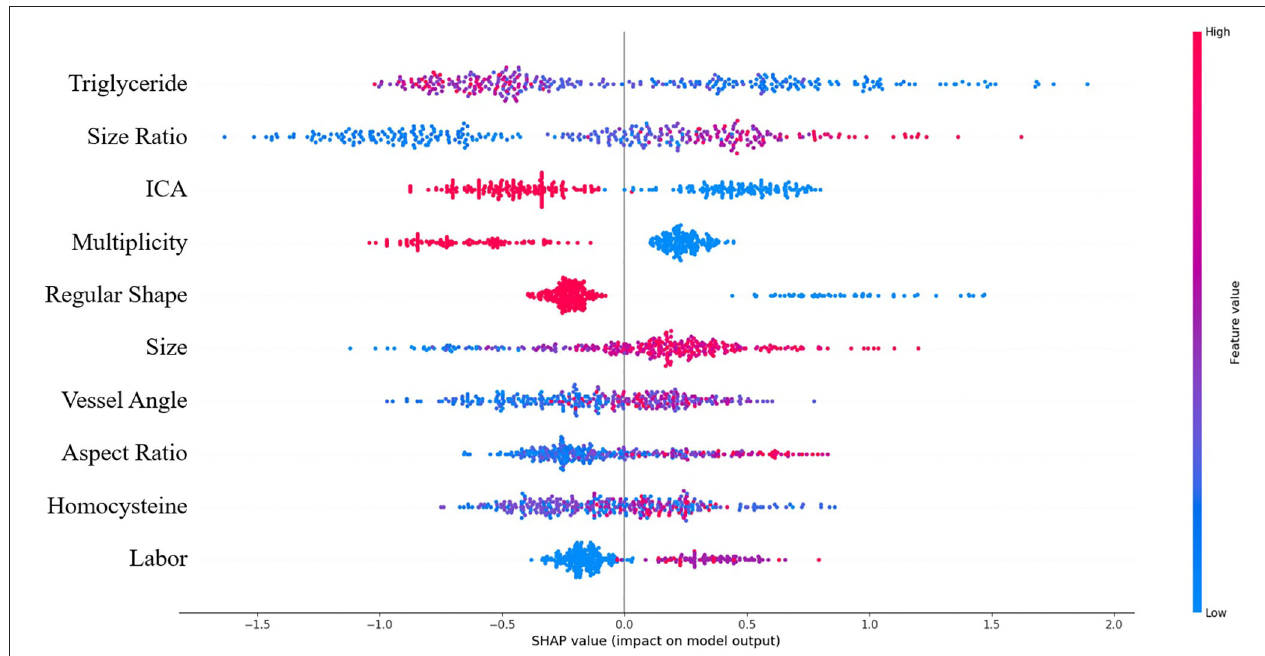
FIGURE 3 | Summary of SHAP analysis on the dataset. This shows the 10 most important features and their impact on the model output. Each dot represents a case in the dataset. The color of a dot indicates the value of the feature, with blue meaning the lowest range and red meaning the highest range. The horizontal axis shows the corresponding SHAP value of the feature. A positive SHAP value contributes to the prediction of rupture and vice